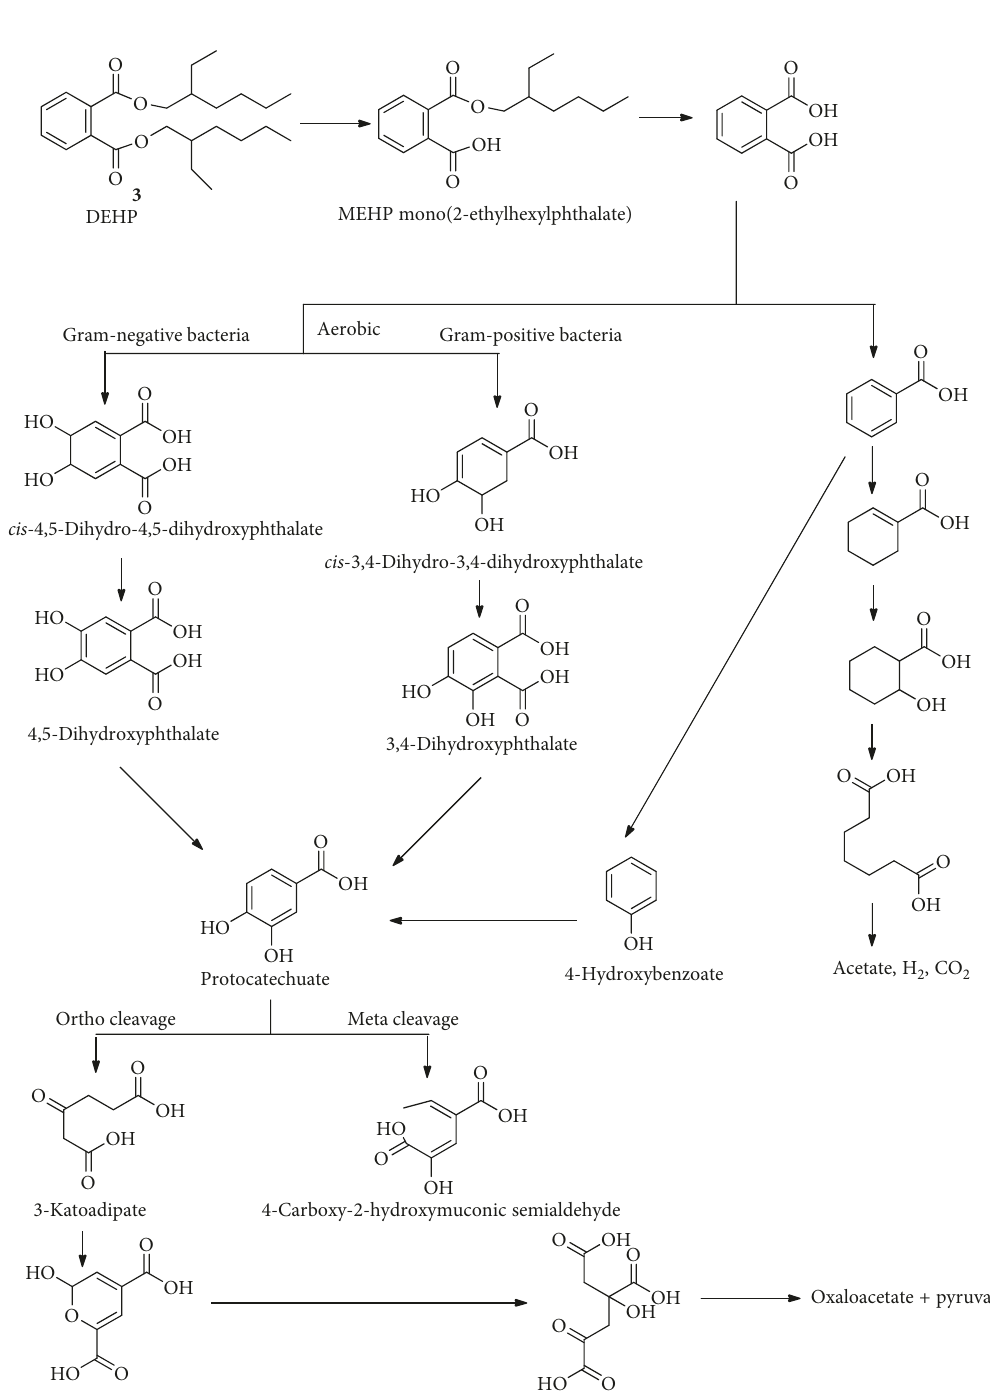
Figure 1: Biodegradation pathway of